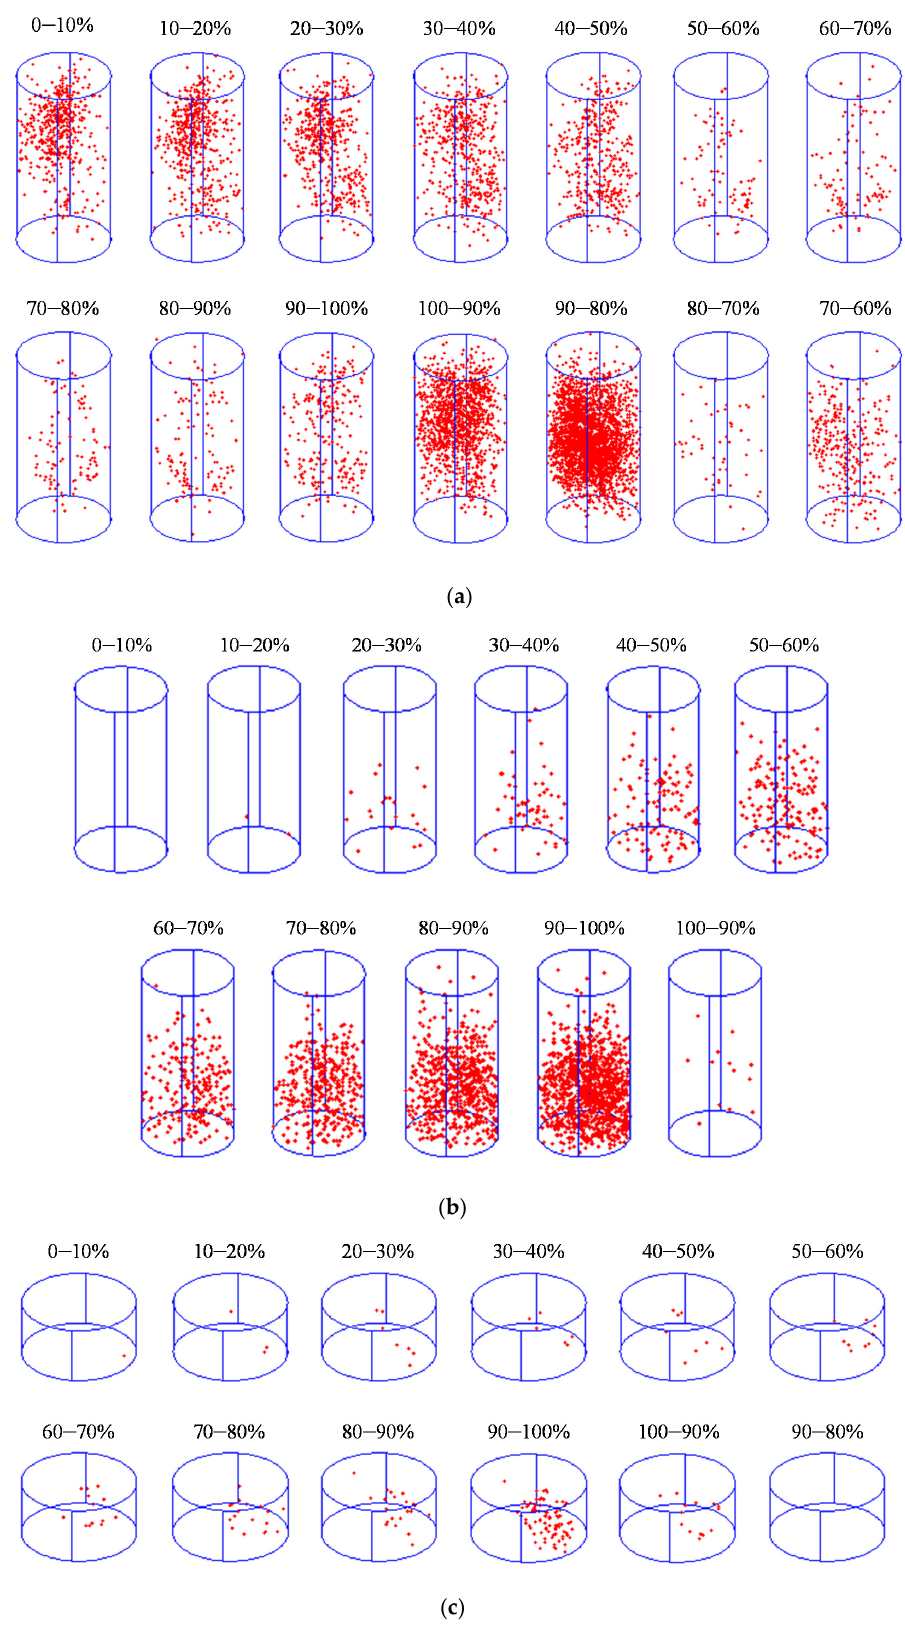
Figure 5. AE event spatial evolution in a typical marble sample under different loading modes: ( a ) UCT, ( b ) DTT, ( c ) ITT. ( b ) DTT, ( c )